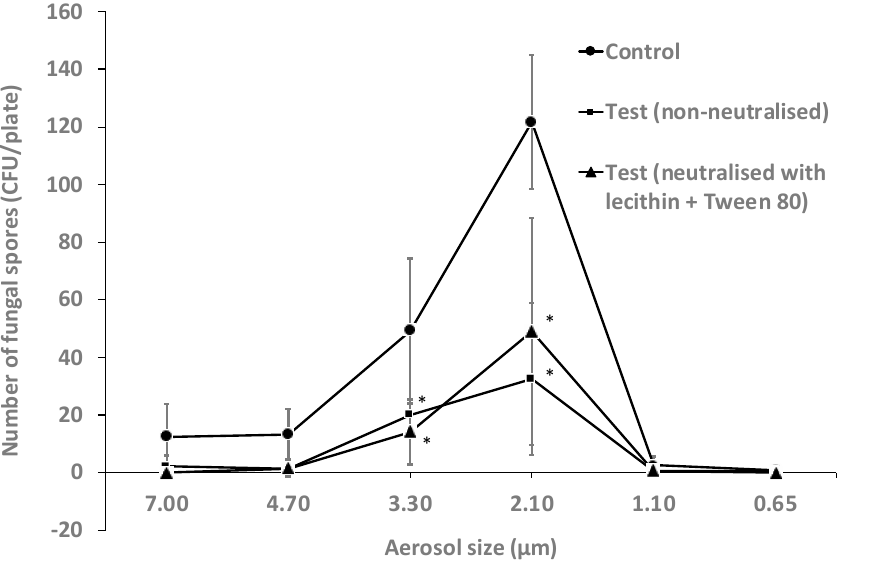
Figure 4. Number of A. flavus spores recovered from different aerosol sizes with or without neutralisation of the vaporized essential oils for 10 min. The essential oils significantly reduced the viability of spores of A. flavus in aerosols sizes 3.30 and 2.10 µm in both neutralised and non-neutralised conditions compared to the untreated control (*, p < 0.05). Data points represent the mean (±95% confidence interval) of three independent experiments. CFU = colony forming units. Table 4. The ability of the antimicrobial gel vaporised for 10 min to reduce the numbers of aerosolised A. flavus spores.